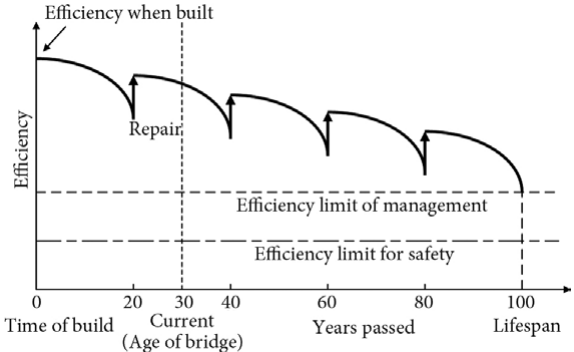
Fig. 3. Outline of bridge lifespan (when bridges last for 100 years) Data source: reference (Ohshima 2009) (This figure is touched up from the original figure by authors) Table 4. The scenarios of population and bridge operation and maintenance budget Bridge operation and Population maintenance budget